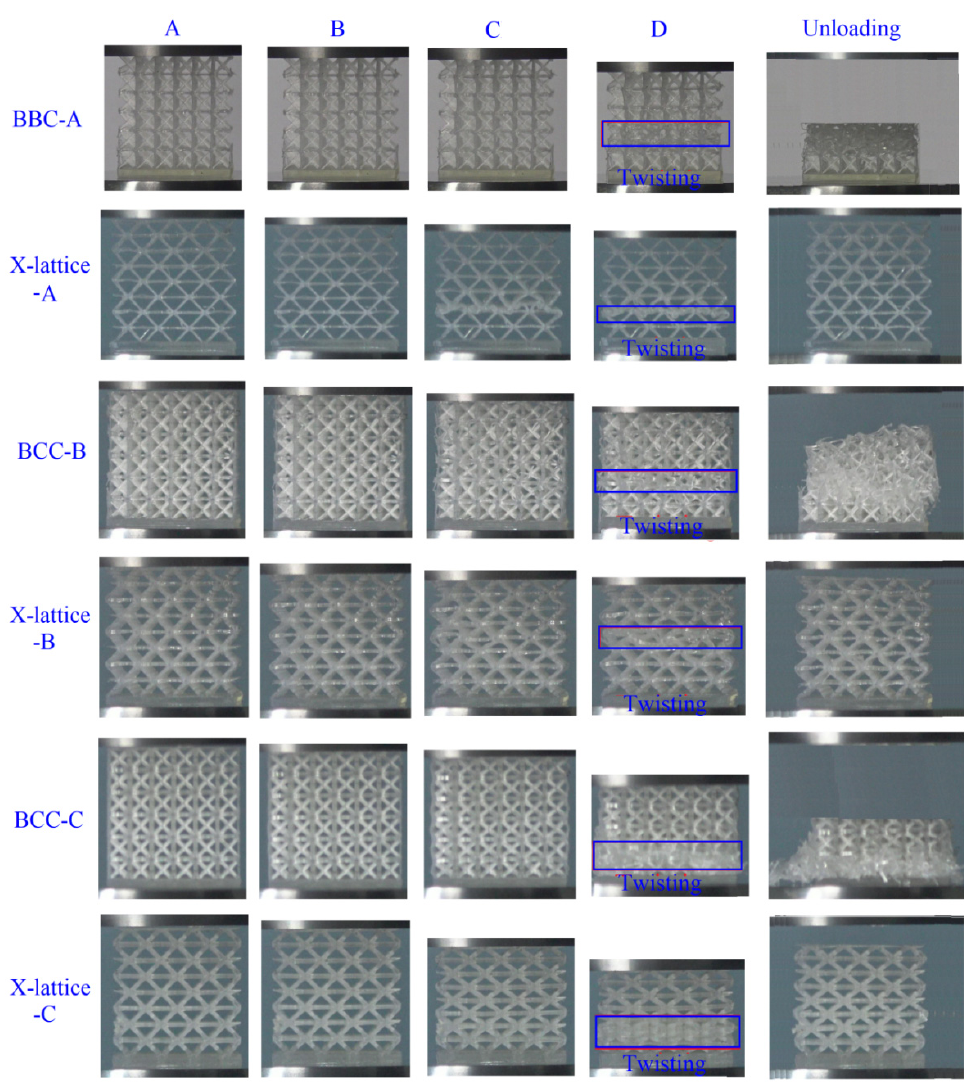
Figure 6. The typical deformation of micro-architectures (Sample A–D).